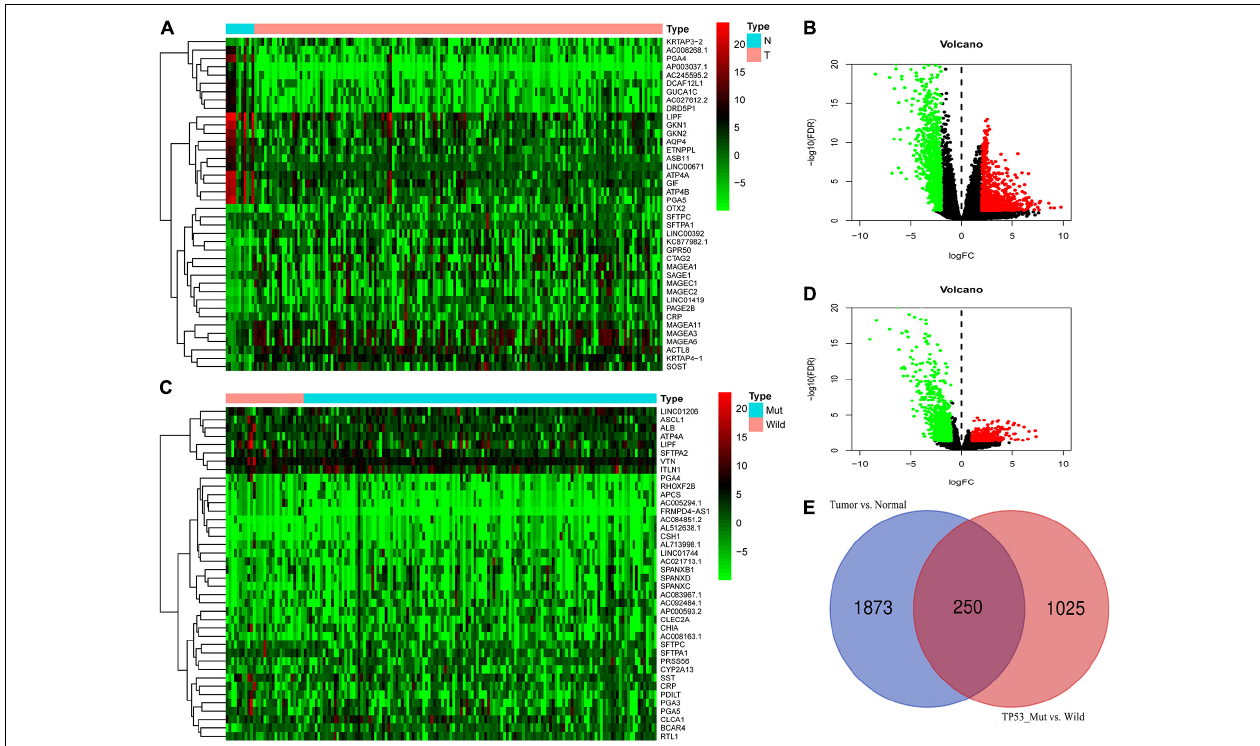
FIGURE 3 | Differential expression analysis (A,B) DEG-2 between ESCA and adjacent tissues. (C,D) DEGs-1 between the ESCA TP53 WT and TP53 MUT cohorts. (E) DEGs-3: intersections of DEGs-1 and DEGs-2. Abbreviations ESCA: esophageal